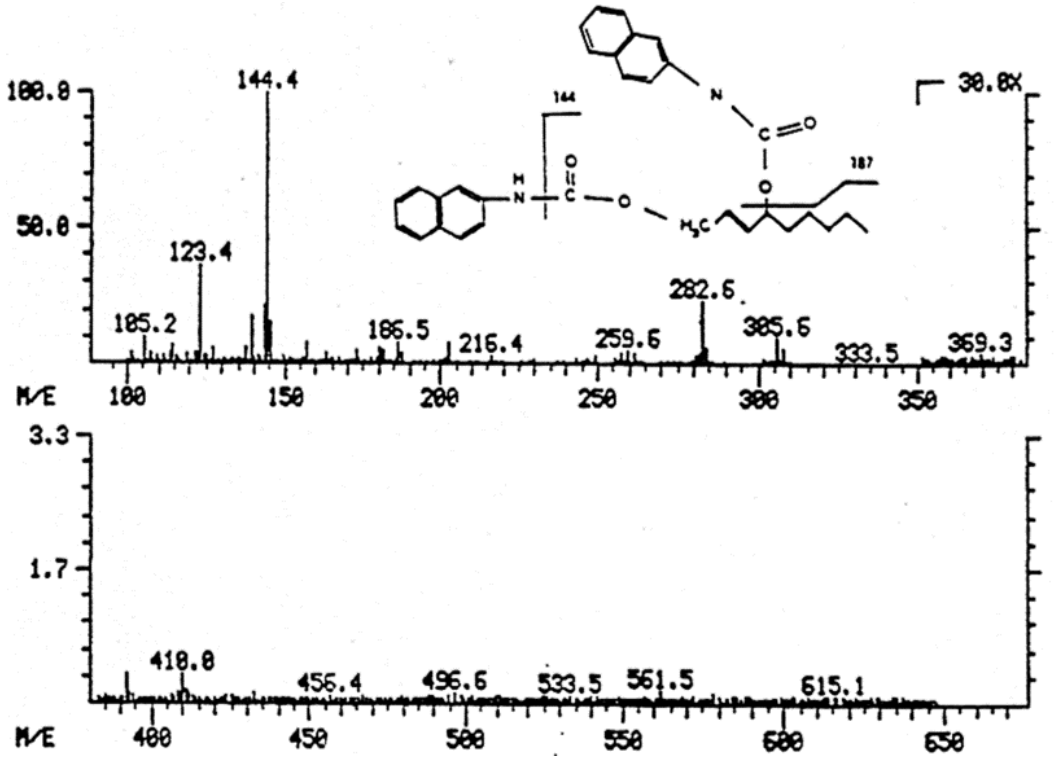
Figure 8. Mass spectrum of dihydroxynonene urethane (HPLC plus MS) with fluorimetric detection. The preparation of the reduced HNE product 1,4-DHN was carried out in the following manner: reduction of HNE with sodium boronate; extraction with dichloromethane; drying by means of sodium sulphate; purification by TLC separation, detection with 10% phosphomolybdenic acid dissolved in ethanol, extraction from TLC plates with CH Cl . Identification of 1,4-DHN: Siliylation; GC 2 2 (85 °C, with 10 °/min up to 150 °C, 50 m SE30 column—i.d. 0.32 mm, FID); formation of urethane derivative (1,4-dinaphthyl-2,3-nonenylurethane); (305, 350 nm). Preparation of radioactively labelled 1,4-DHN: Reduction of radioactively labelled HNE with sodium boronate; extraction with dichloromethane; purification by means of TLC and elution on Bond Elut C18 columns (35% methanol/water, v/v). Chemical ionization (CH ). Peaks: m/e 4 + , m/e 187 Ar-NH-COOH, m/e 123 (M + 1)-(2 × 187); (M + 1) = 497 m/e 144 Ar-NH 3